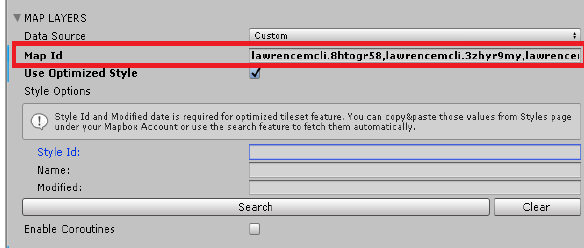
Figure 8. Field for entering MapID of tileset in Unity3D